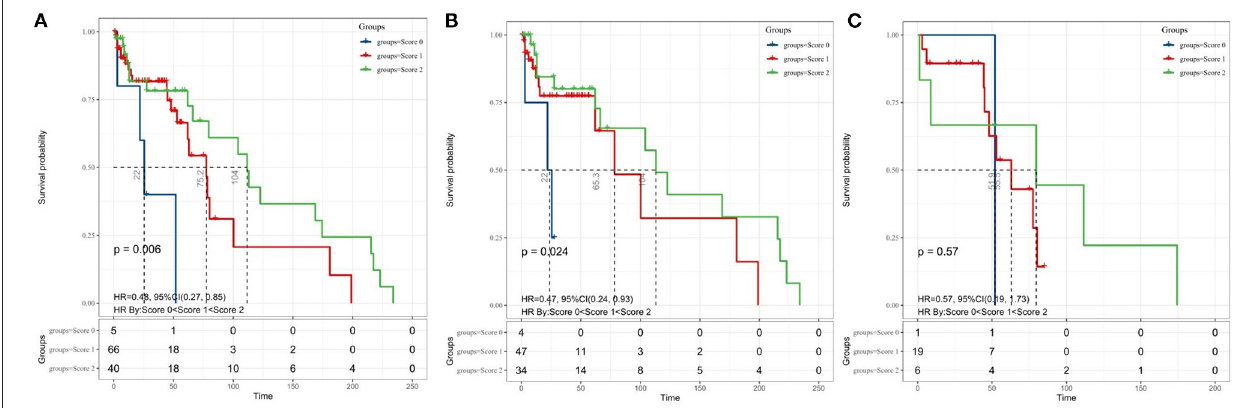
FIGURE 4 | The Kaplan–Meier survival curves for OS according to the combination of SII and PNI in patients with medulloblastoma. (A) entire cohort; (B) patients aged < 18 years; and (C) adult patients. coSII–PNI, combination of SII and PNI; SII, systemic immune-inflammation index; PNI, prognostic nutritional index.